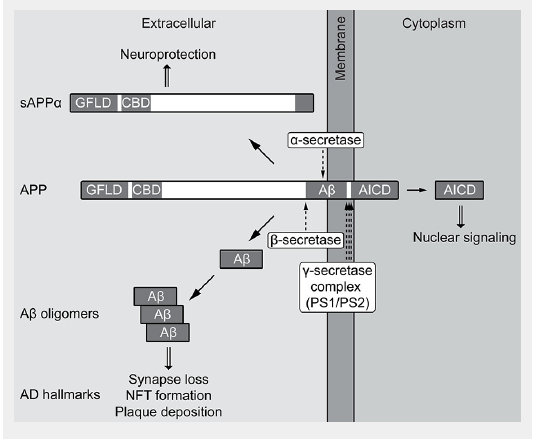
Proteolytic processing of the amyloid precursor protein (APP). APP is a single-pass transmembrane protein with a large extracellular domain and the short APP intracellular domain (AICD) facing the cytoplasm. Sequential proteolytic cleavage by the secretases occurs via two opposing pathways, both initiated by the release of the extracellular domain. Non-amyloidogenic cleavage by α-secretase destroys the Aβ peptide and releases secreted APPα (sAPPα). This APP fragment contains a growth factor-like domain (GFLD) and a copper-binding domain (CBD) and displays neuroprotective and neuroproliferative properties. In the amyloidogenic pathway, cleavage by β-secretase generates the Aβ N-terminus and sAPPβ, which lacks the properties of sAPPα. After release of the extracellular domain, the remaining APP transmembrane C-terminal fragments (CTFs) can enter the γ- secretase complex to undergo regulated intramembrane proteolysis (RIP), which consists of consecutive cleavages denoted by three arrows. This initially releases AICD from the membrane, which in the case of the amyloidogenic pathway can signal to the nucleus. In the same pathway, further cleavages by γ-secretase shape the Aβ C-terminus that is critical for determining aggregation propensity.